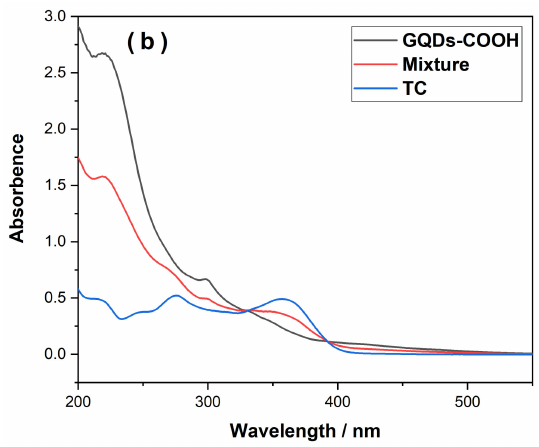
Figure 3. ( a ) Fluorescence emission spectra of GQDs with different functional groups with addition of TC in water. ( b ) UV spectrum of GQDs-COOH, TC and mixture.